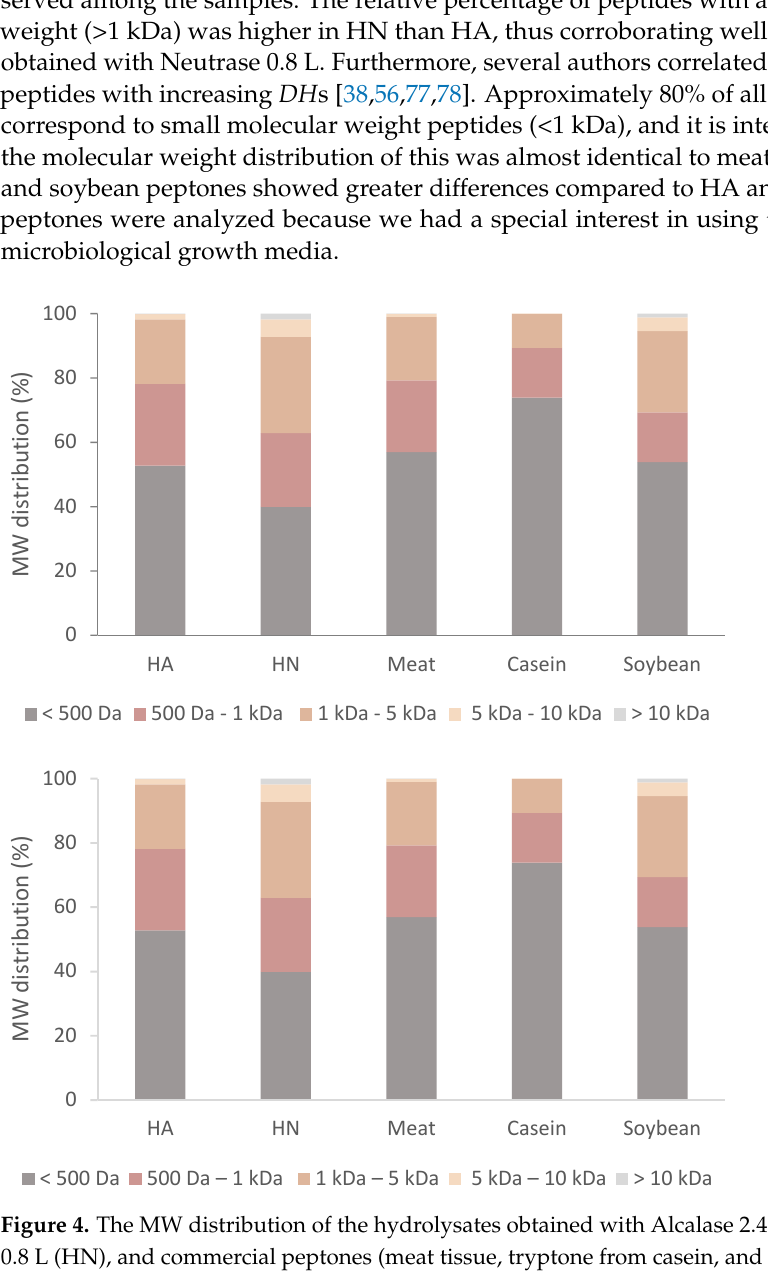
Figure 4. The MW distribution of the hydrolysates obtained with Alcalase 2.4 L (HA) and Neutrase 0.8 L (HN), and commercial peptones (meat tissue, tryptone from casein, and